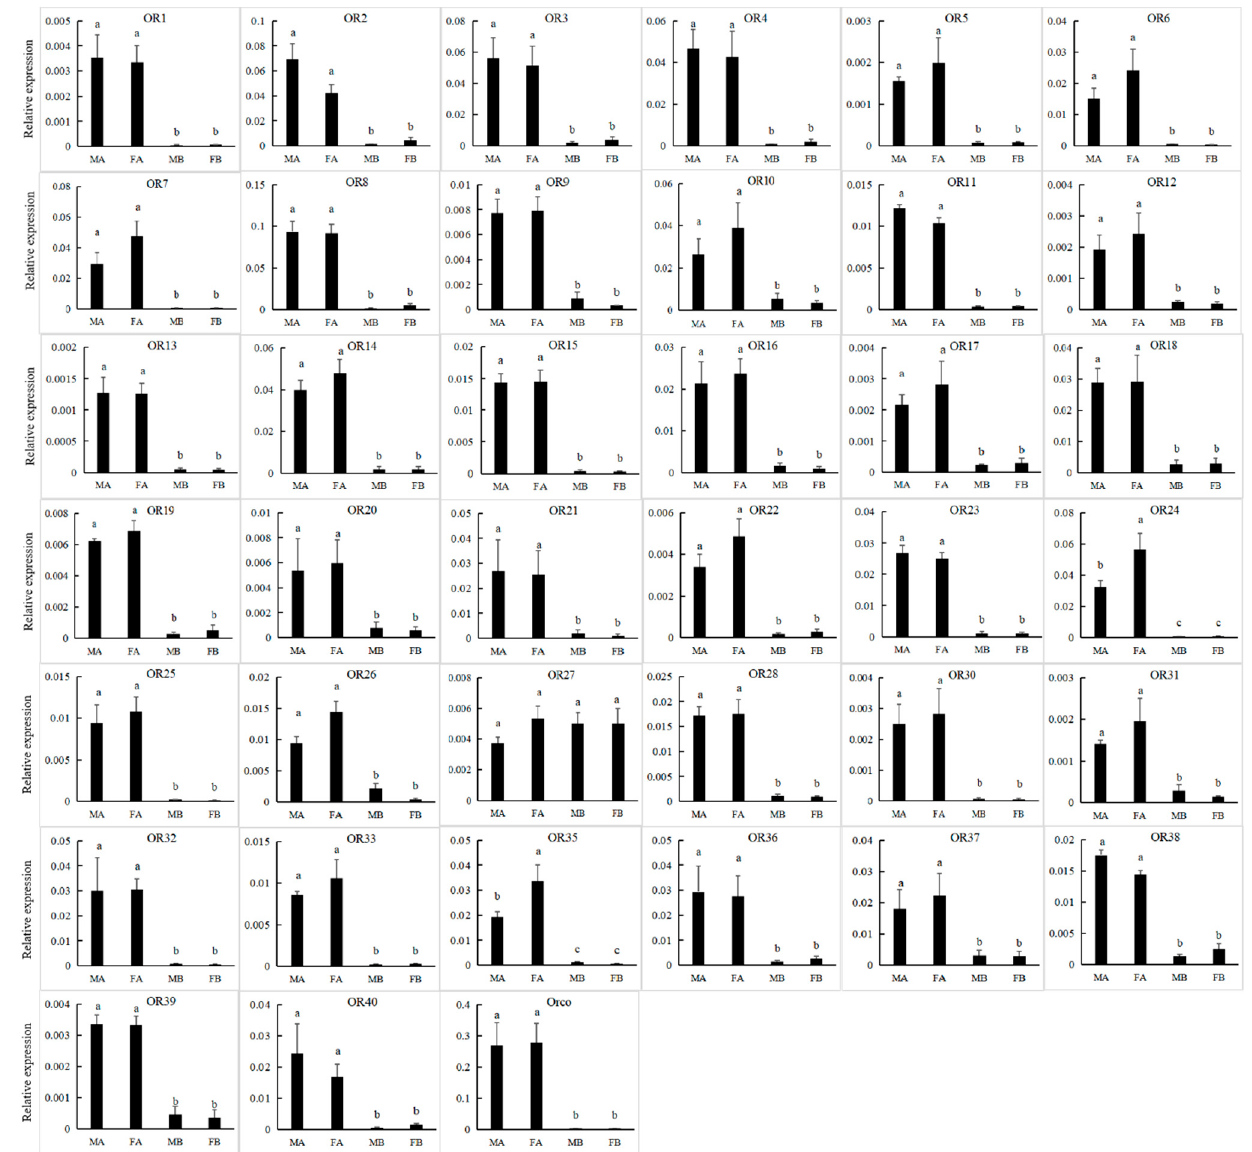
Figure 7. Expression levels of PverOR genes in different tissues assessed by RT-qPCR. MA, male antennae; FA, female antennae; MB, male body (without antennae); FB, female body (without antennae). Error bars, r, are represented by standard error of three biological replicates. Different letters (a, b) indicate significant differences ( p < 0.05) of male or female based on one-way ANOVA.